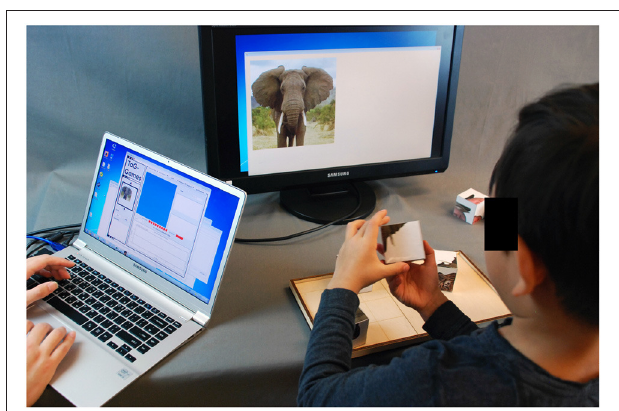
FIGURE 1 | Study setting: The TAG-Games technology consists of a set of SIG-Blocks, an interfacing computing device (e.g., a laptop) for administration and monitoring, and an extra screen for displaying test items. This picture shows a child using four SIG-Blocks with segmented animal faces to match the displayed image. Parent consent was obtained for publication of this